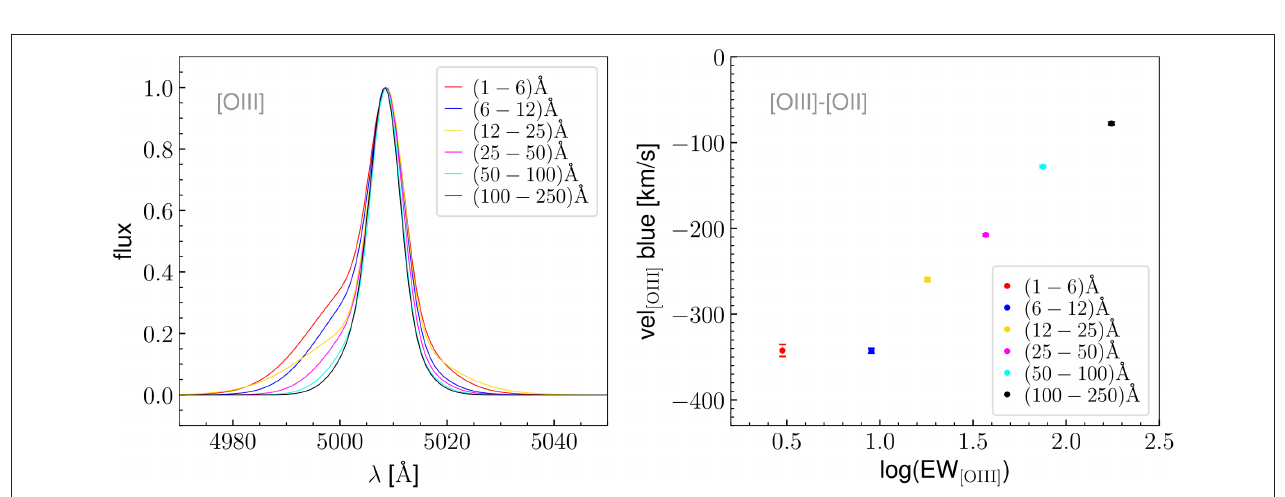
FIGURE 1 | Full Width Half Maximum, Inter-Percentile Velocity width and dispersion σ as a function of the EW[OIII] for the H β line. All these quantities, describing the rotational velocity of the gas orbiting around the central SMBH, increase moving from low to high EW[OIII] as expected if the BLR is disc-shaped and we are moving from face-on to edge-on positions.